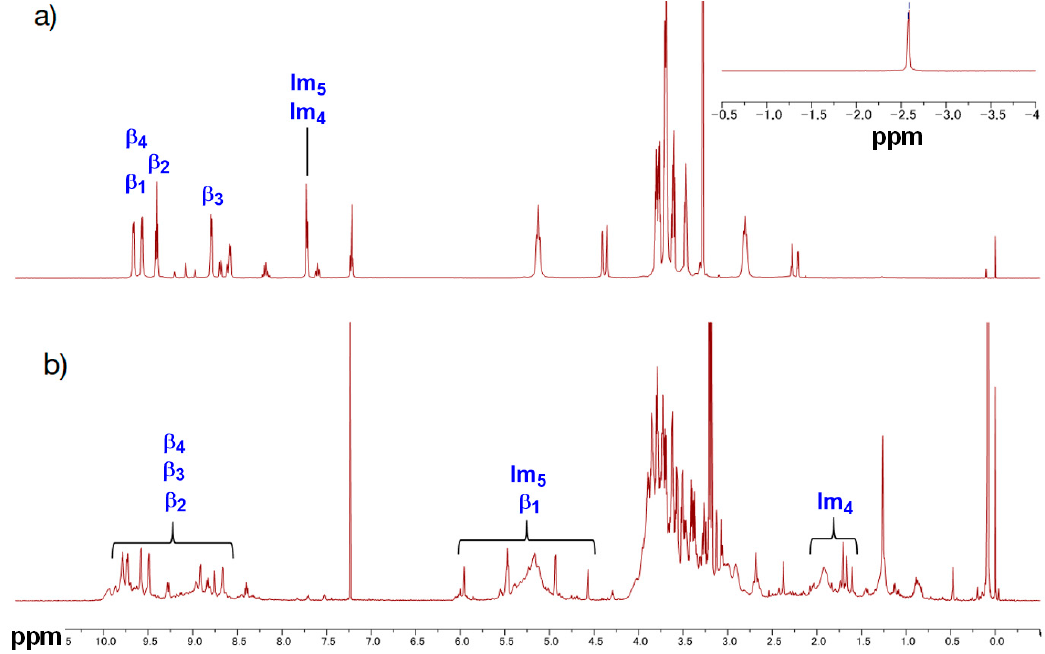
Figure 9. 1 H-NMR (400 MHz, CDCl 3 ) spectra of ( a ) GP1Fb and ( b ) GP1 .